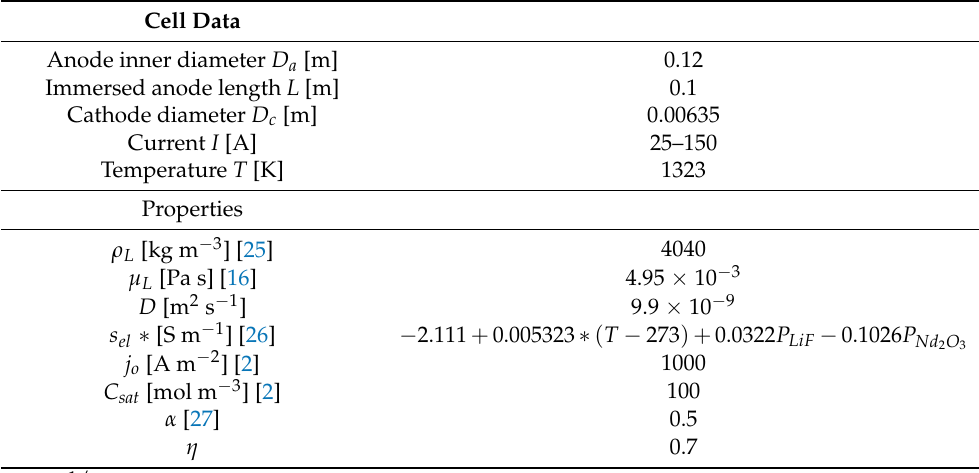
Table 1. Electrochemical cell geometry and